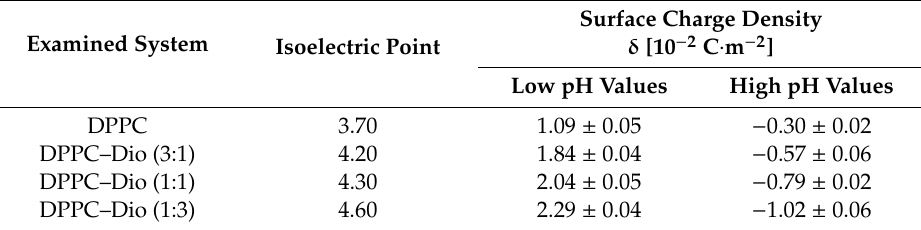
Table 3. Membrane surface charge densities and isoelectric points for the DPPC-Dio system.